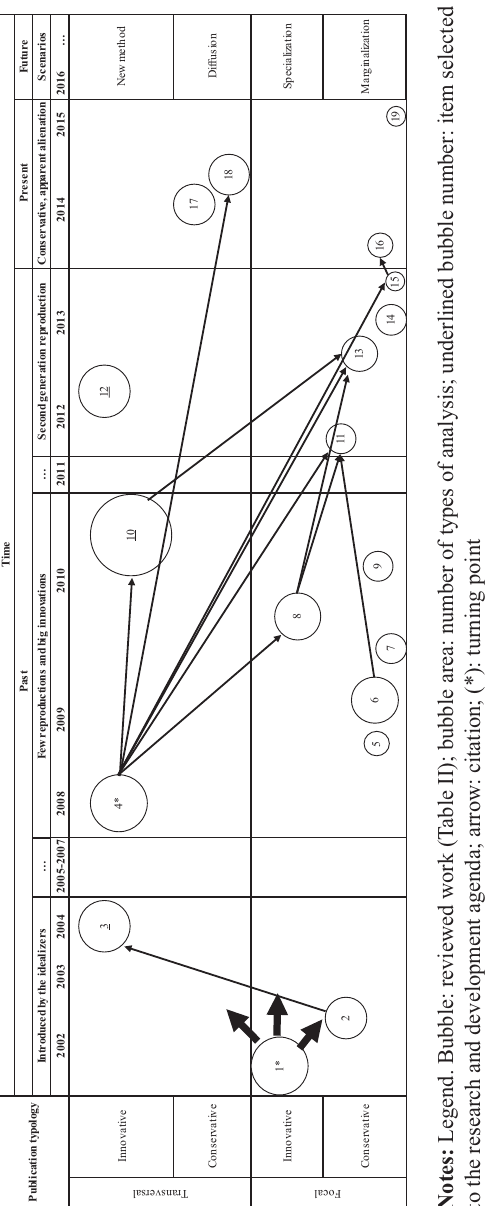
Figure 1. Methodological roadmap of